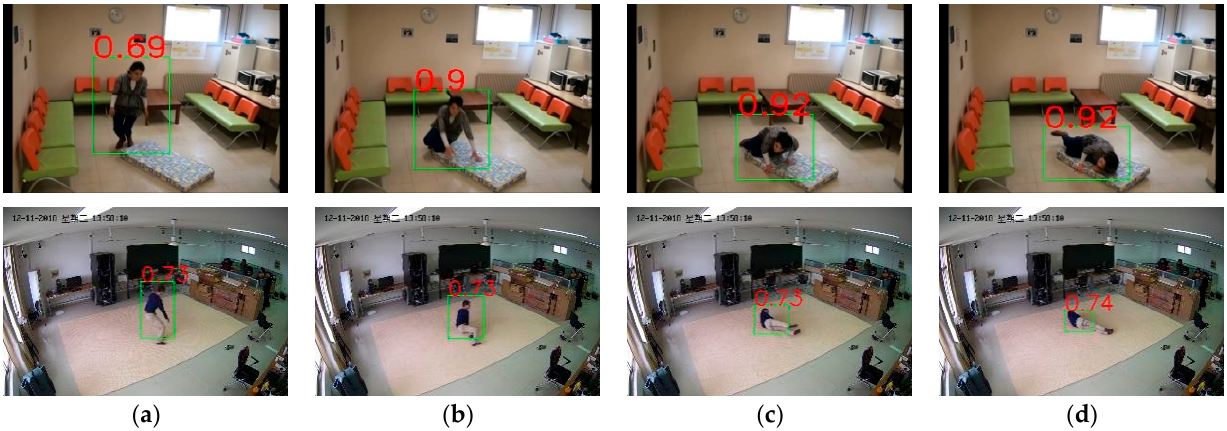
Figure 6. Two instances of falls correctly detected. The top row comes from Le2i dataset, the down row comes from LSST dataset. The numbers on the green boxes are the confidence scores averaged by adjacent outputs: ( a ) The first frame of the fall process; ( b ) The tenth frame of the fall process; ( c ) The twentieth frame of the fall process; ( d ) The thirtieth frame of the fall process.